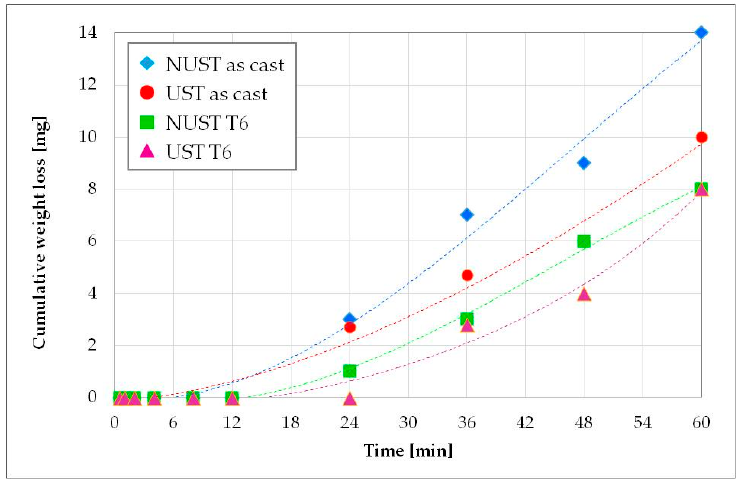
Figure 6. Incubation period.